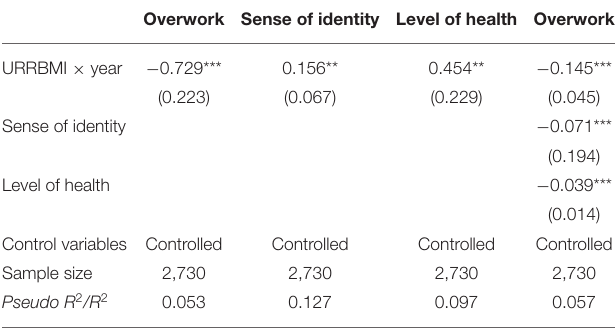
TABLE 7 | Impact path of URRBMI on migrant workers’ overwork. Overwork Sense of identity Level of health